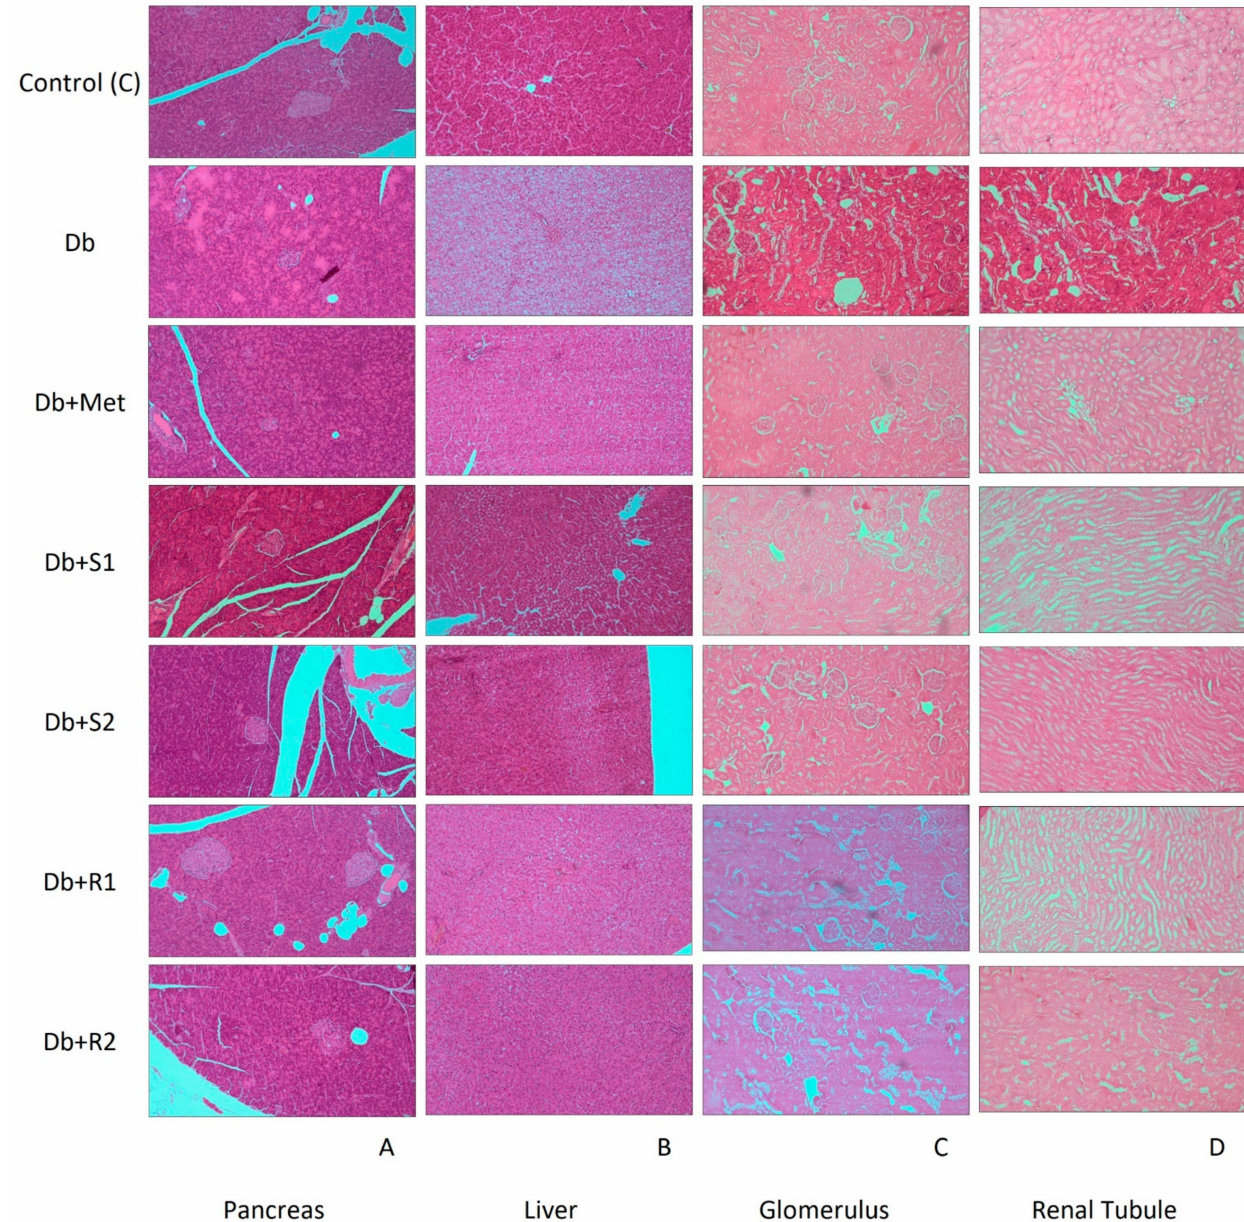
Figure 5. Effect of diet and supplementary SGs on histological alterations of pancreas, liver, and kidneys. Internal cross-sections of ( A ) pancreas, ( B ) liver, ( C ) kidneys—glomerulus, and ( D ) kidneys—renal tubules (10 ×